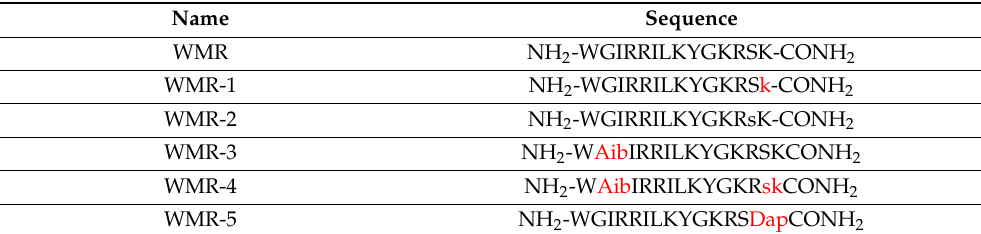
Table 2. Peptide sequences of WMR and its analogues designed in this study. The amino acids used in our study are represented in red.